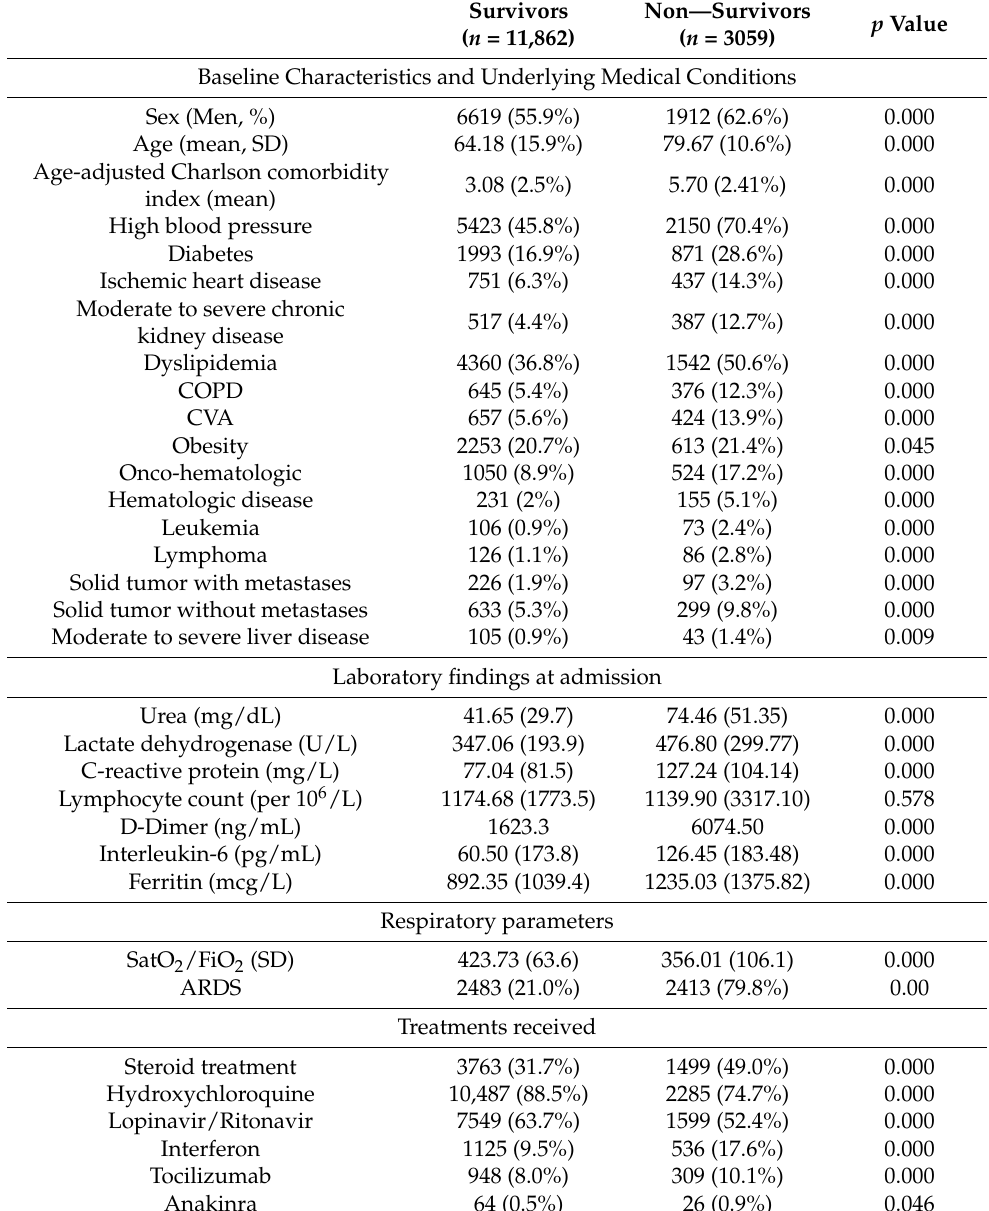
Table 2. Baseline characteristics of patients in the survivor and non-survivor